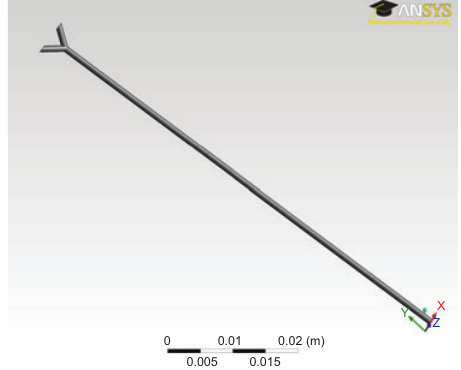
Figure 1 Model domain of the Y-mixer used in the CFD